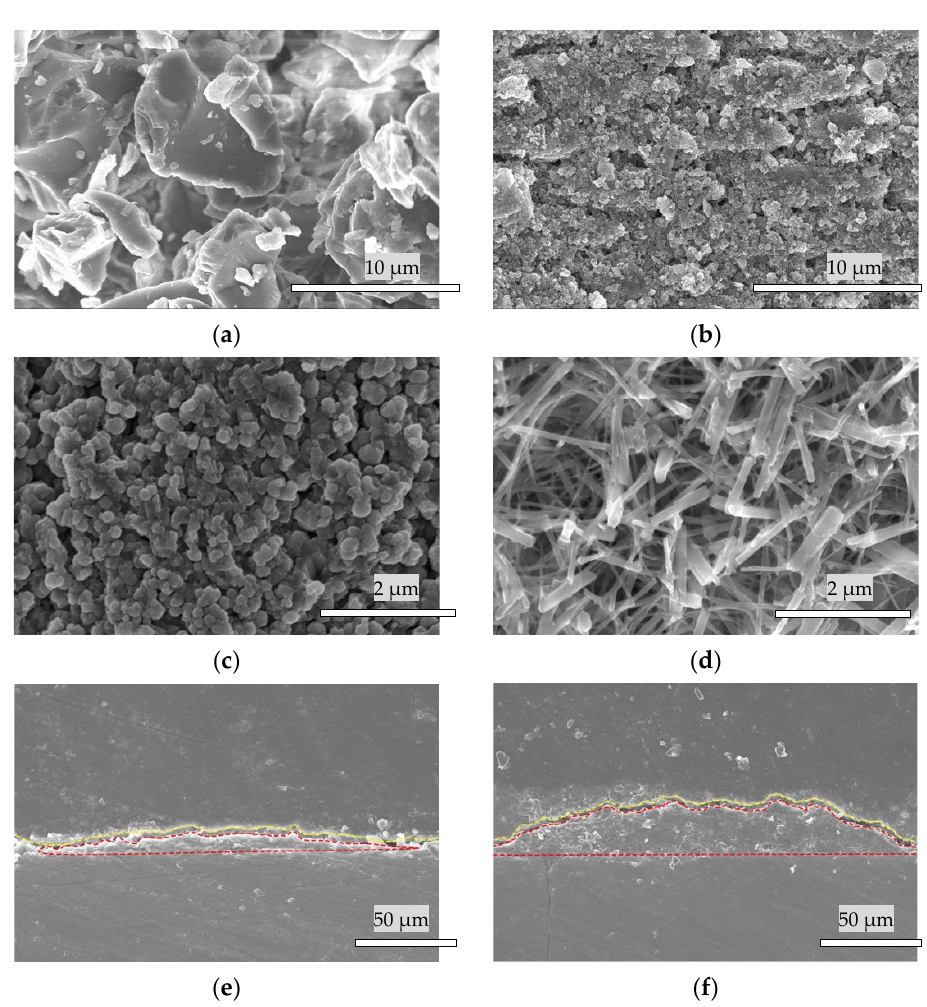
Figure 4. SEM images of ( a ) (10 kV) α‐ TCP powder, the deposition of α‐ TCP layer by ( b ) (10 kV) 1 pulse and ( c ) (5 kV) 25 pulses of Er:YAG ‐ PLD. ( d ) (15 kV) Plate ‐ like crystallites of HAp after hydrolyzation by 25 pulses of PLD. The cross ‐ sectional SEM of HAp coated specimens by one pulse ( e ) (10 kV) and 25 pulses of Er:YAG ‐ PLD ( f ) (10 kV) following hydrolyzation.